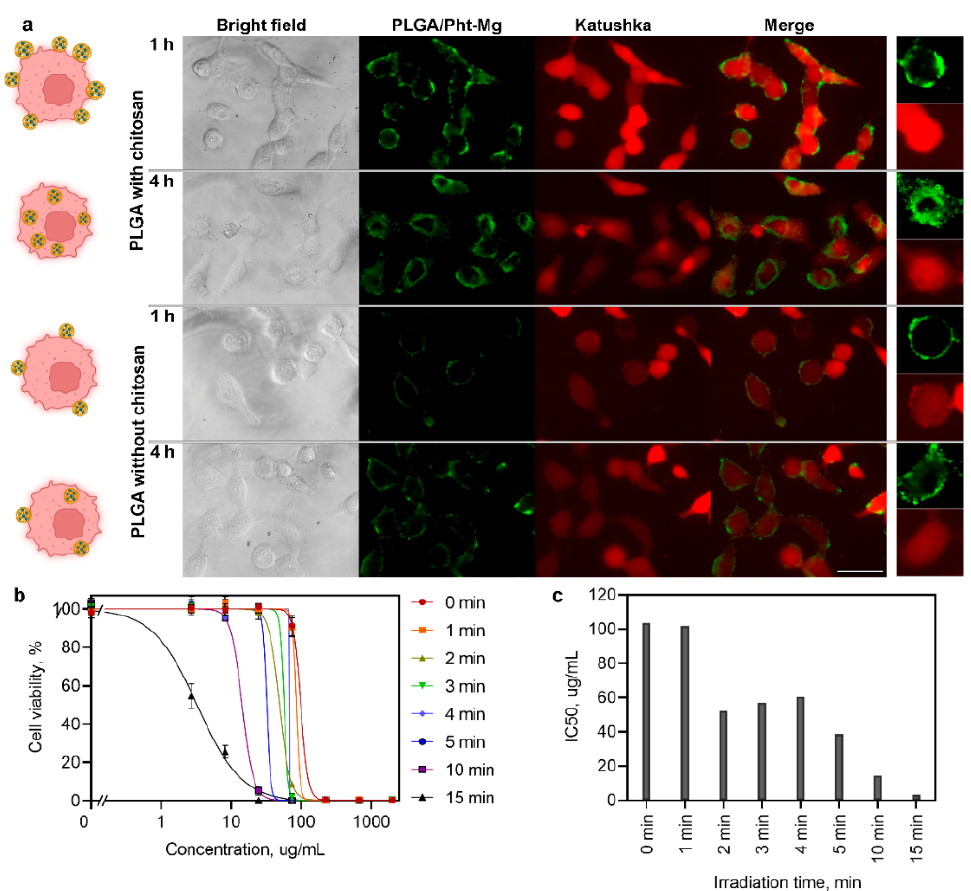
Figure 2. PLGA nanoparticles loaded with Pht-Mg and coated with chitosan oligosaccharide lactate effectively penetrate the cell membrane and possess cytotoxic properties under the 808 nm light irradiation. ( a ) Fluorescence microscopy study of PLGA/Pht-Mg nanoparticles interaction with cells. SKOVip-Kat cells were incubated with PLGA/Pht-Mg particles loaded with Pht-Mg with or without chitosan coating during the synthesis. Cells were imaged 1 h and 4 h after the incubation. Images were taken in a bright field, in the fluorescence channel corresponding to the PLGA/Pht-Mg fluorescence (excitation filter − 560/40 nm, emission filter − 630/75 nm) and Katushka fluorescence (excitation filter − 560/40 nm, emission filter − 630/75 nm). Scale bar, 20 µm. ( b ) Light-induced photothermal toxicity of PLGA/Pht-Mg particles for SKOVip-kat cells. Cells were incubated with PLGA/Pht-Mg and irradiated with an 808 nm laser. Cell viability was evaluated 72 h after the irradiation in dependence on particle concentration and irradiation time. ( c ) IC50 dependence on irradiation time for 72 h viability